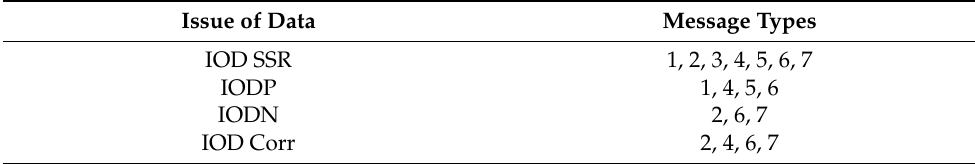
Table 2. Defined issue of